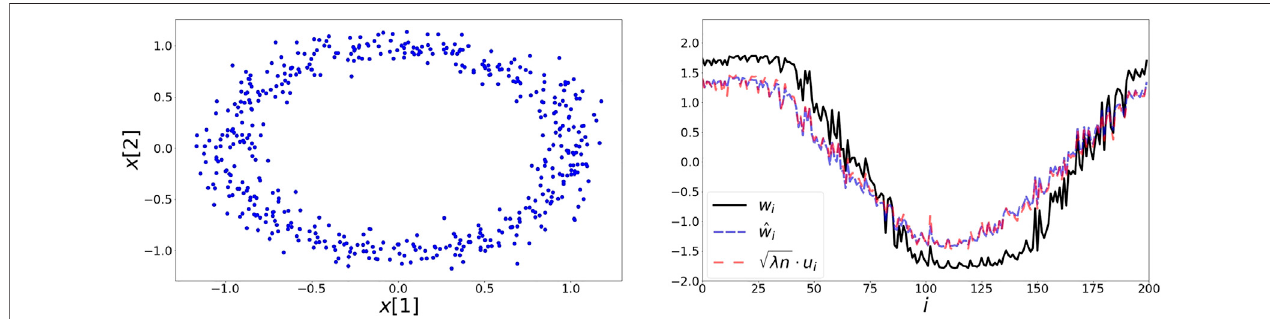
FIGURE 2 | Left: 200 elements on the noisy circle data set. Points are generated by adding noise drawn from a two dimensional Gaussian with zero mean and a varianceof0.1. Right: Theextractedrepresentationsbasedonthesymmetricloss w ,secondorderapproximation (cid:13) w andleadingeigenvector u .In Figure7 ,wepresent (cid:12)(cid:12)(cid:12) √ λ n a scatter plot comparing the values of (cid:13) w and u .